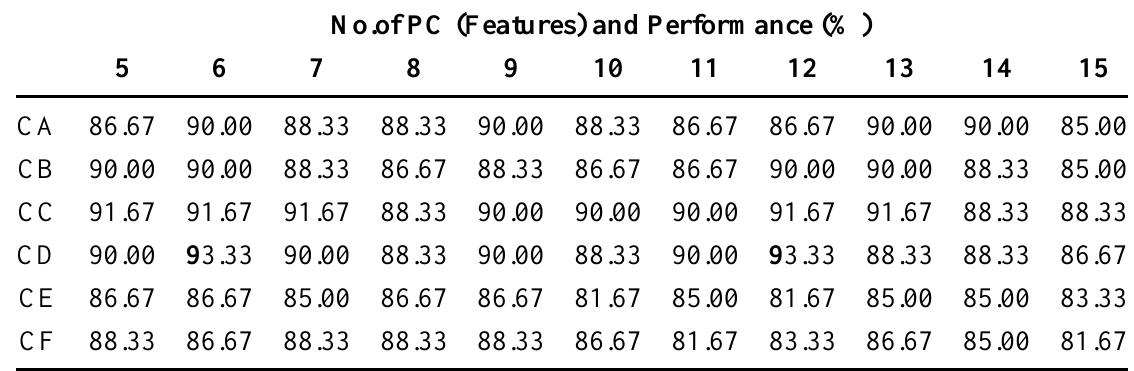
Table 8. Oil palm FFB ripeness classification accuracy for method MB (5–15